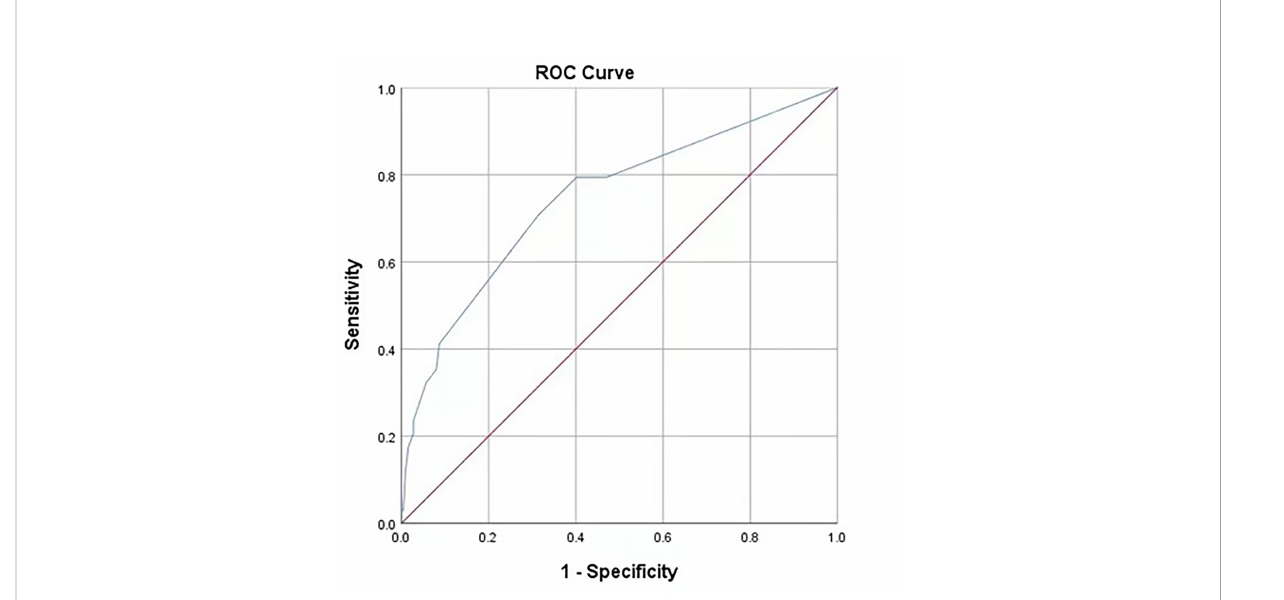
FIGURE 3 Receiver operating characteristic curves of the predictive model on the training data. AUC (95%CI)=0.745 (0.650-0.840). The areas under receiver operating characteristic curves were 0.745±0.048 (P < 0.001). The ideal area under the curve was 1.00. The reference line represents that based on chance alone (area under the curve